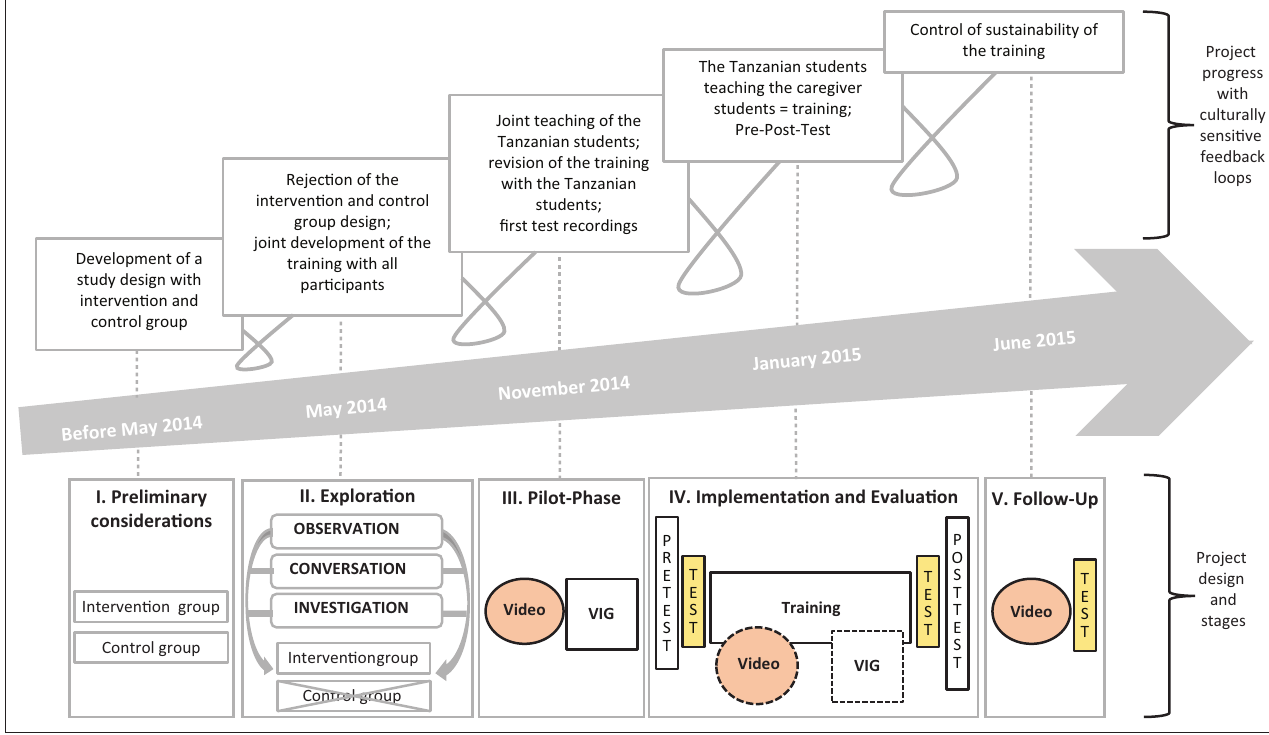
FIGURE 3: Culturally sensitive study